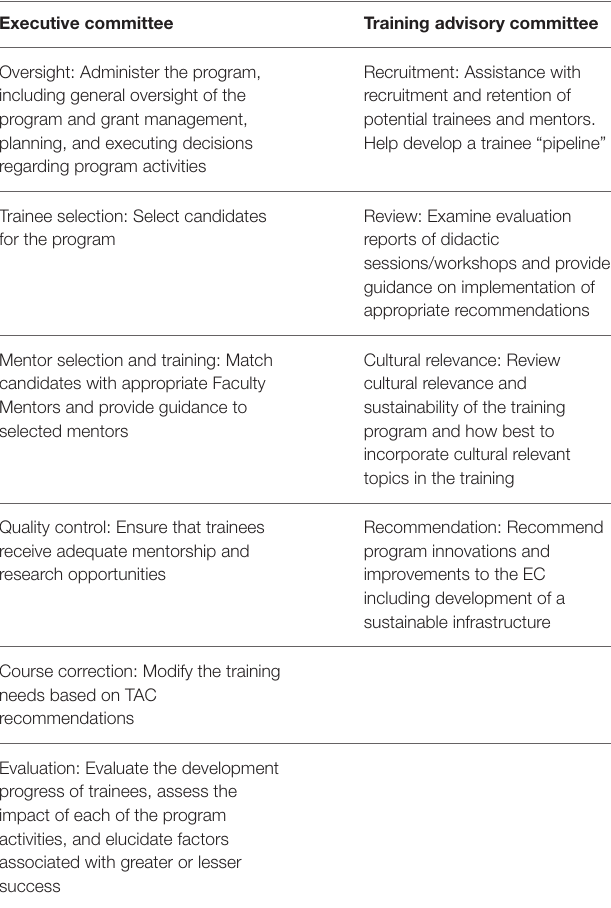
TABLE 3 | Roles and responsibilities of EC and